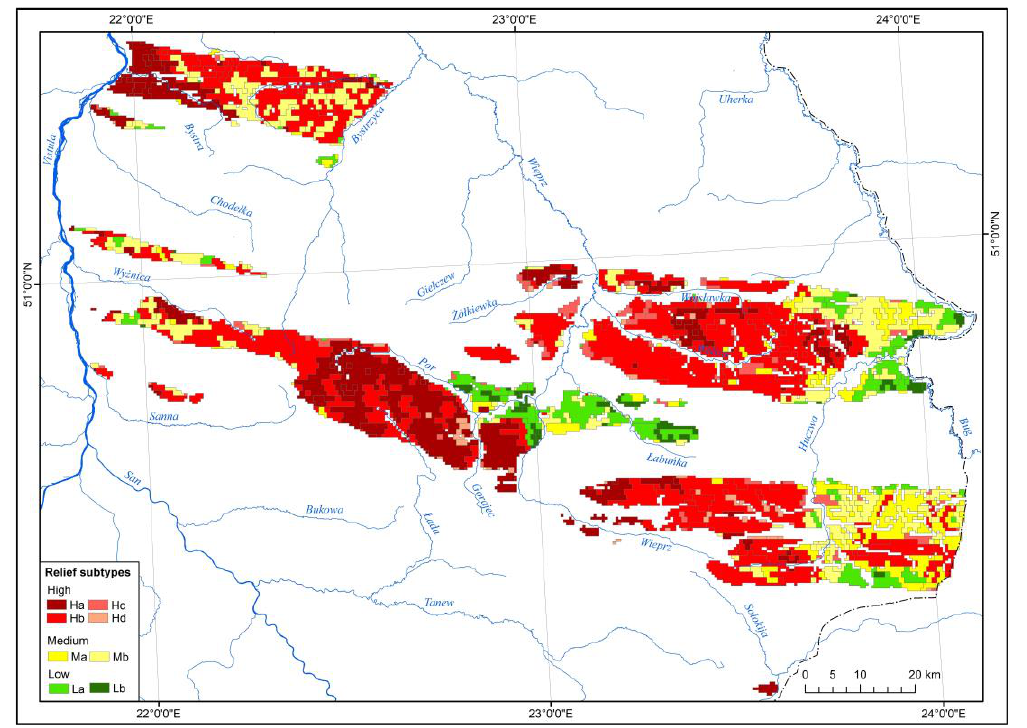
Figure 6. Subtypes of relief. Table 4. Basic statistical parameters of segments’ distance matrix, classified into relief types and